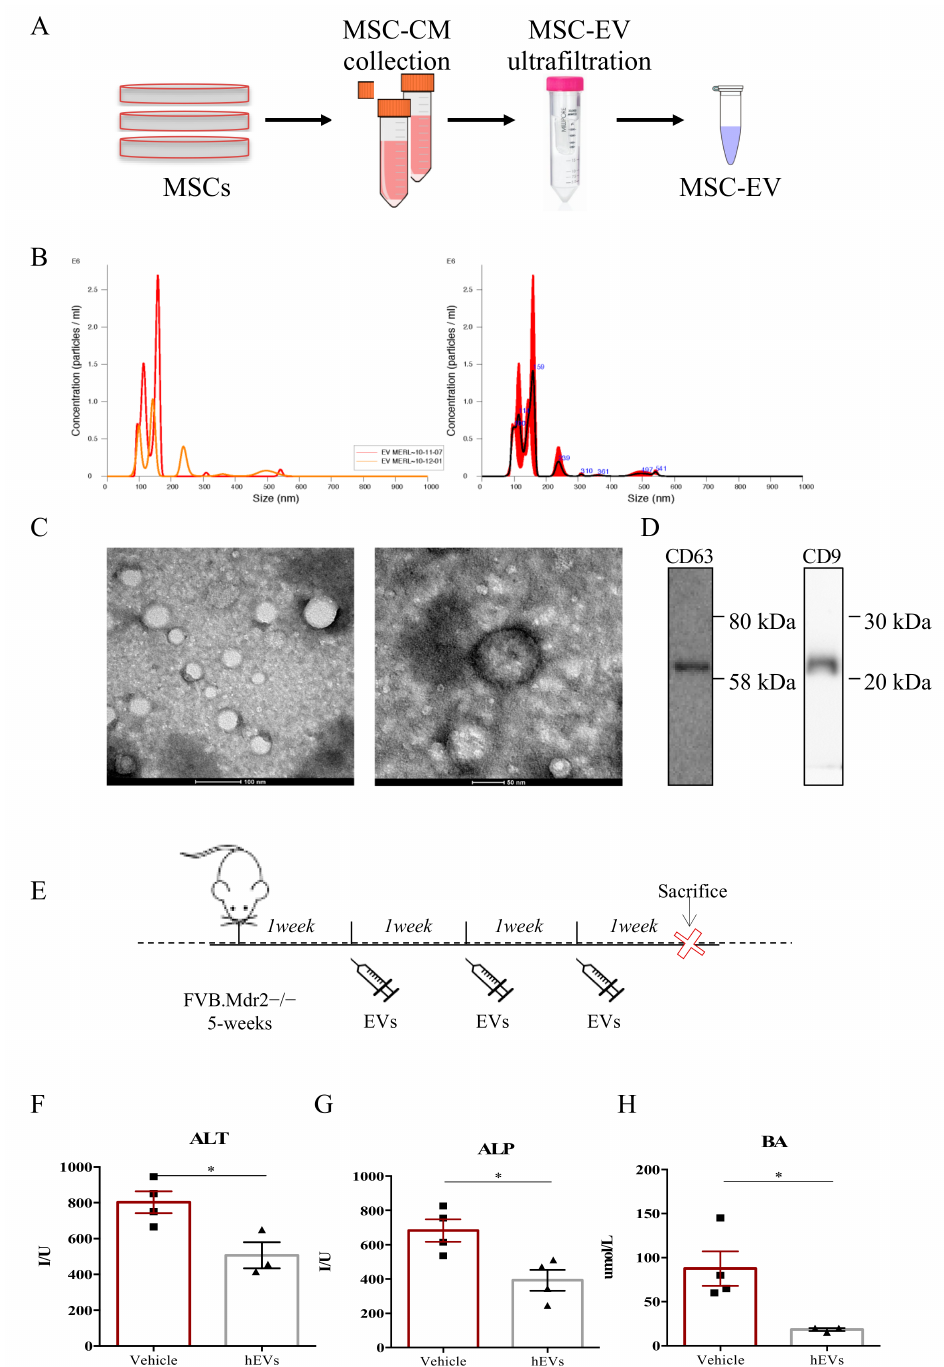
Figure 1. MSC-derived EVs reduce liver damage in FVB.Mdr2 − / − mice. ( A ) Illustration of the purification protocol of EVs from human MSCs. ( B ) Analysis of absolute size distribution and concentration of